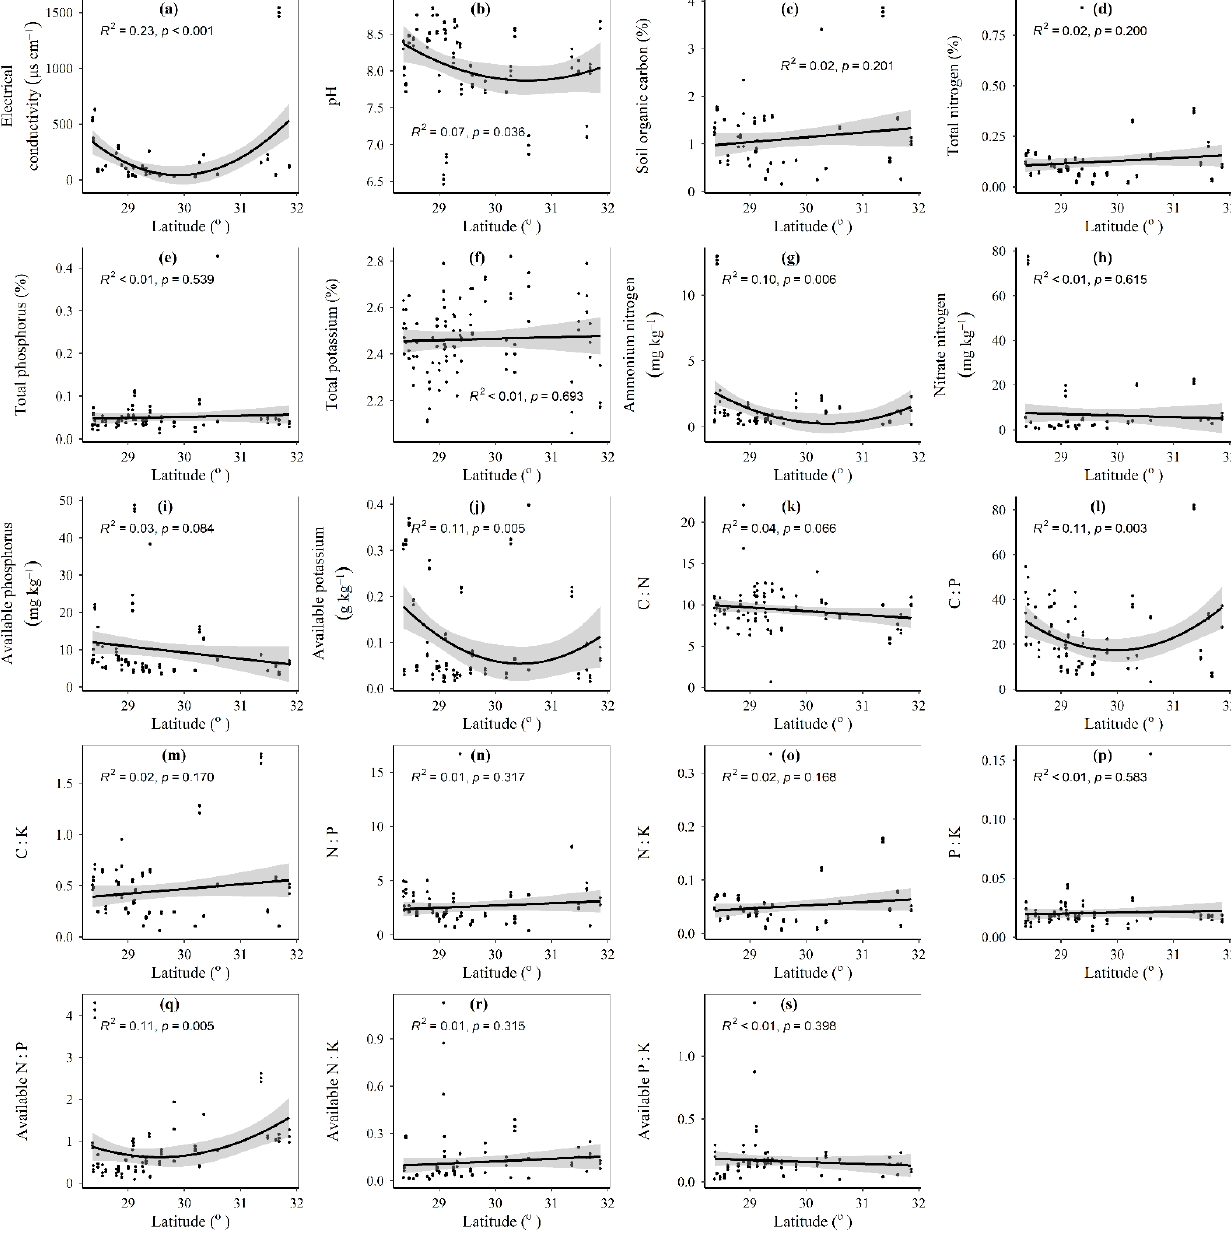
Figure A9. Relationships of latitude with soil ( a ) electrical conductivity, ( b ) pH, ( c ) soil organic carbon (SOC), ( d ) total nitrogen (TN), ( e ) total phosphorus (TP), ( f ) total potassium (TK), ( g ) ammonium nitrogen (NH 4+ -N), ( h ) nitrate nitrogen (NO 3 − -N), ( i ) available phosphorus (AP), ( j ) available potassium (AK), ( k ) ratio of SOC to TN (C:N), ( l ) ratio of SOC to TP (C:P), ( m ) ratio of SOC to TK (C:K), ( n ) ratio of TN to TP (N:P), ( o ) ratio of TN to TK (N:K), ( p ) ratio of TP to TK (P:K), ( q ) ratio of available nitrogen to AP (available N:P), ( r ) ratio of available nitrogen to AK (available N:K) and ( s ) ratio of AP to AK (available P:K) at a depth of 10–20 cm.